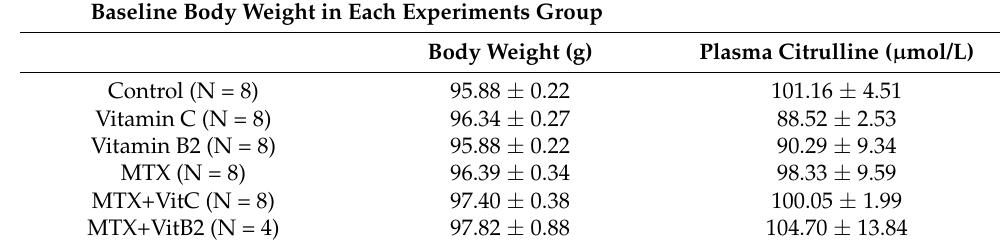
Table 1. Baseline body weight in each experimental group (mean ± SEM). Animals were randomized according to the body weight and plasma citrulline levels.